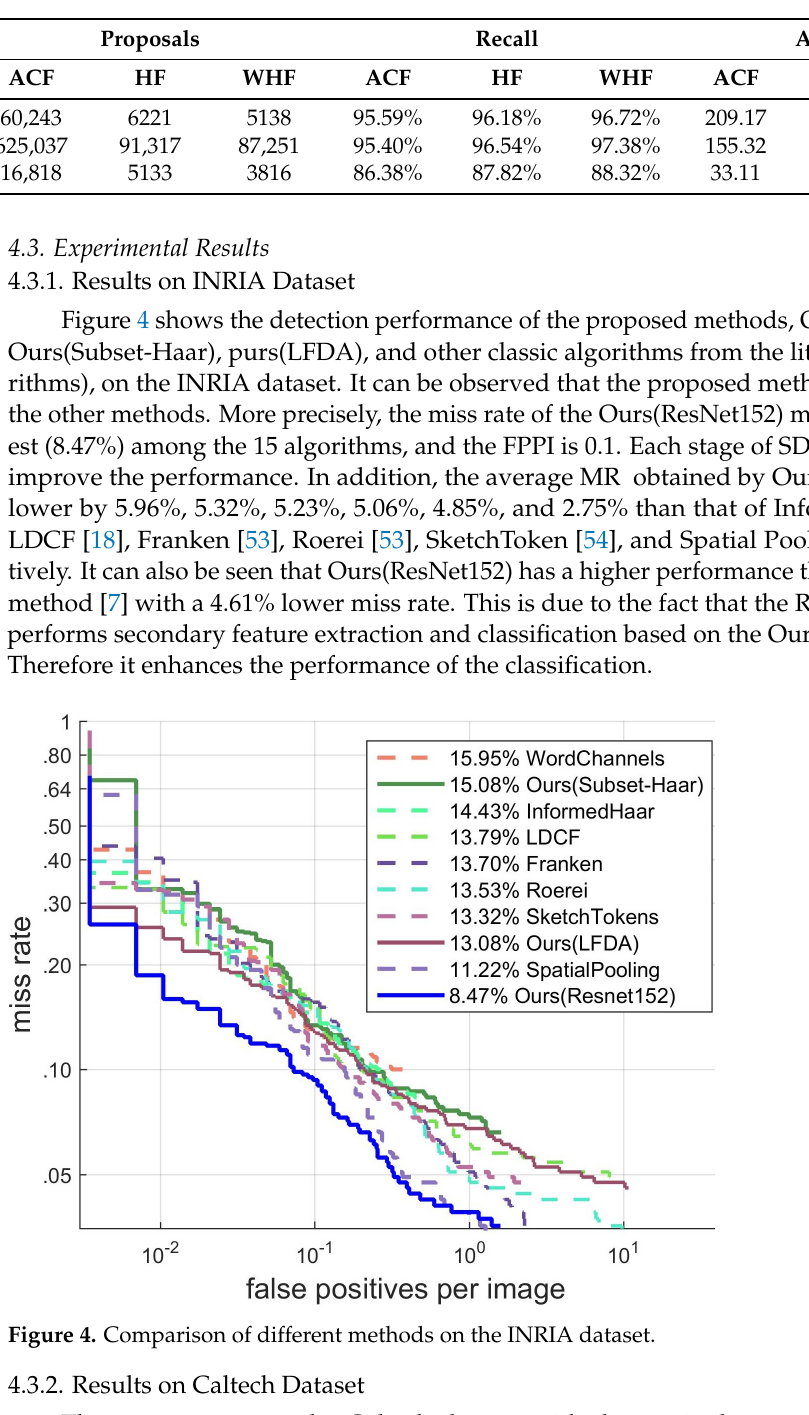
Table 3. Pedestrian Proposals on Different Datasets.